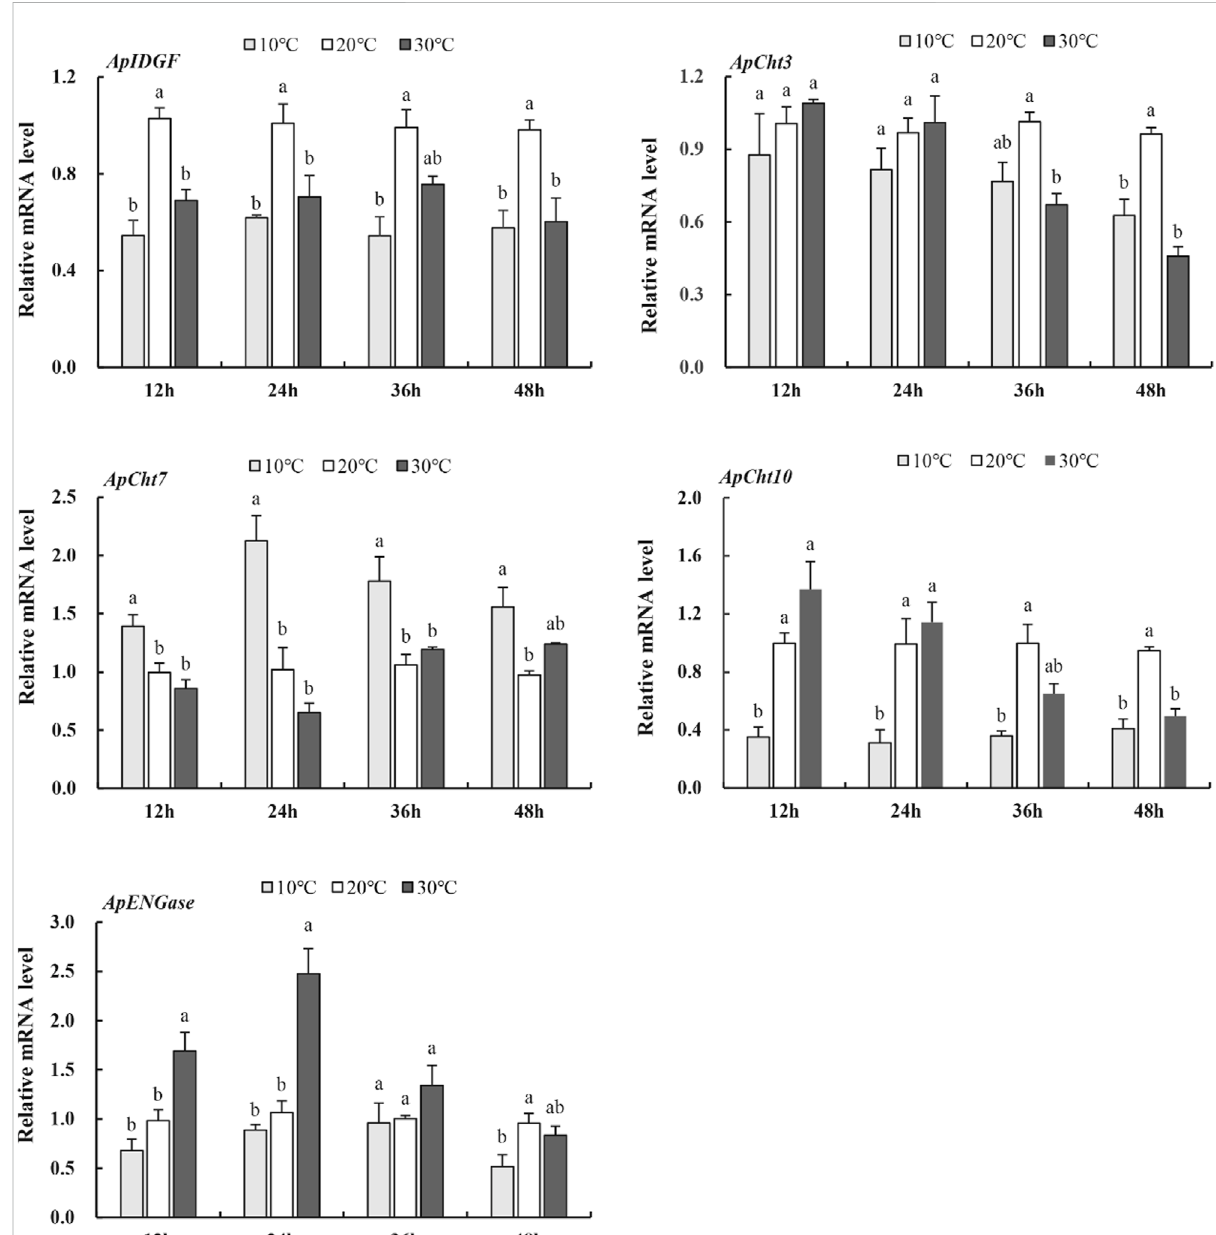
FIGURE 5 Expression of the chitinase genes in response to temperature stress. Different letters on the top of the columns indicate signi fi cance in the difference of expression levels by Tukey ‘ s HSD test at same treatment time ( p <